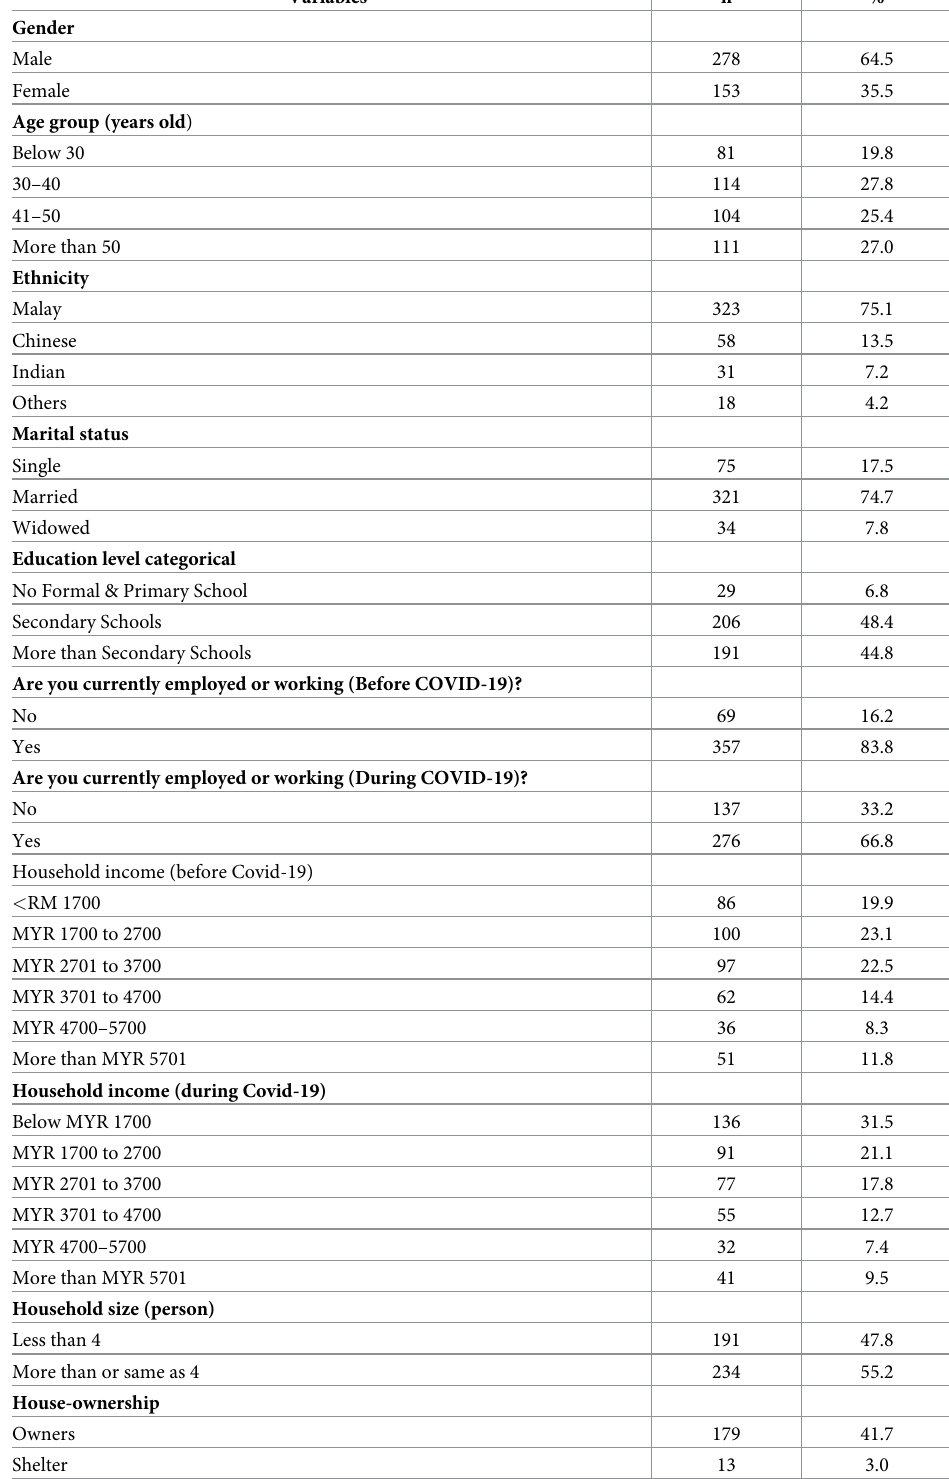
Table 1. Socio-demographic profiles of low-income respondents from the Petaling district (n =